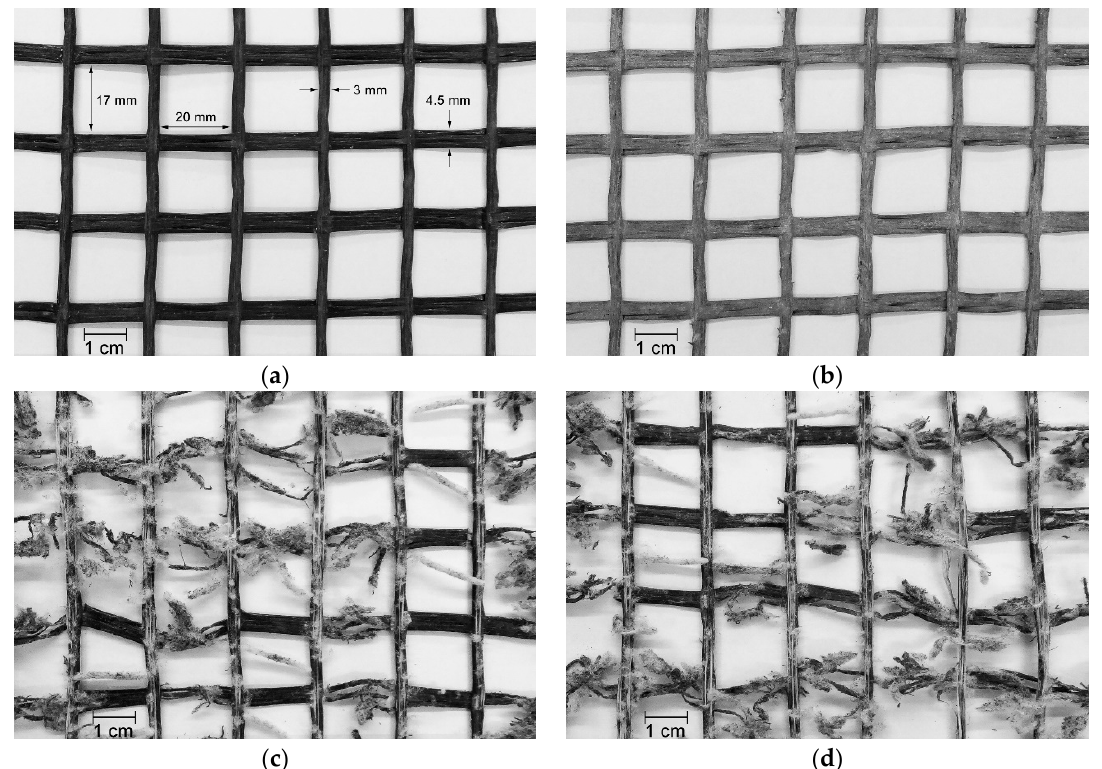
Figure 6. Visual inspection of geogrid GG40II: ( a ) undamaged sample; ( b ) after mechanical damage under repeated loading; ( c ) after abrasion; ( d ) after successive exposure to mechanical damage under repeated loading and abrasion.